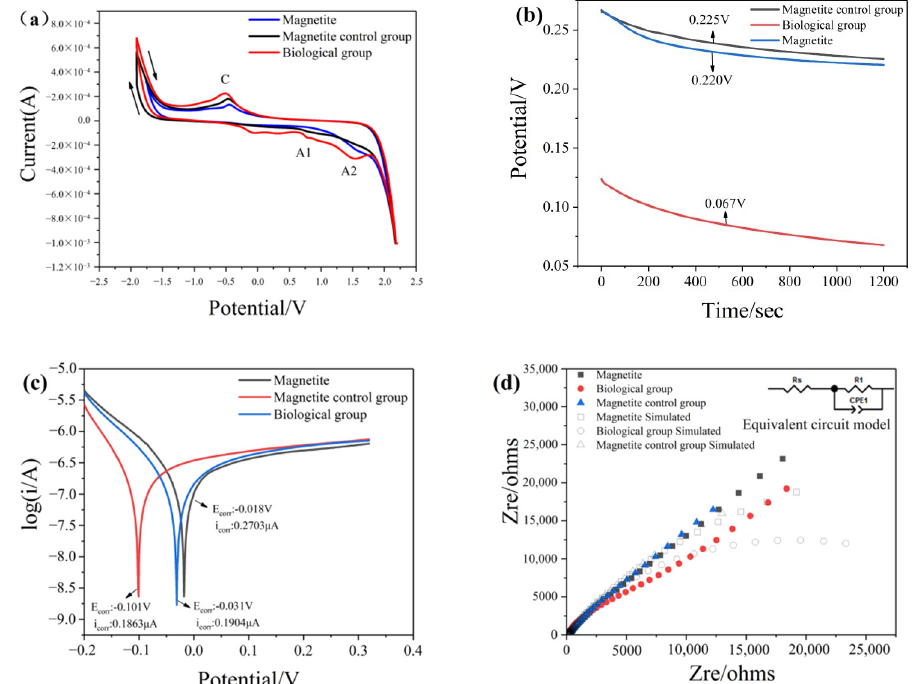
Figure 7. Electrochemical analysis of magnetite before and after treatment with or without chromium solution: ( a ) Cyclic voltammetry curves; ( b ) Open circuit potential; ( c ) Tafel curves; ( d ) Nyquist impedance spectra